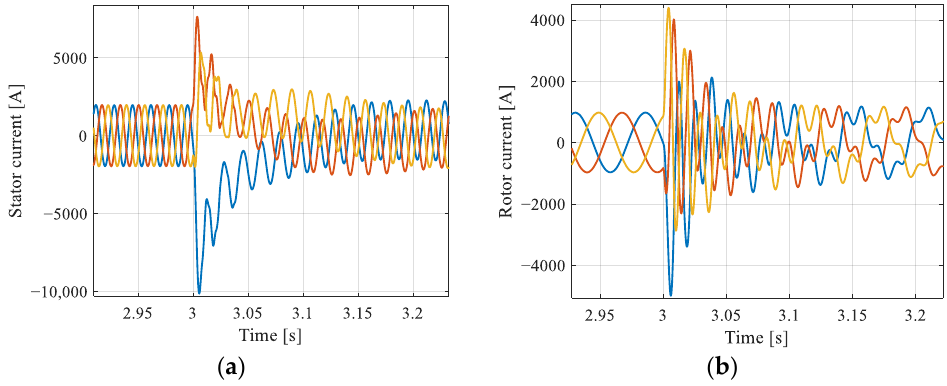
Figure 6. Currents during a balanced voltage sag: ( a ) stator currents and ( b ) rotor currents.